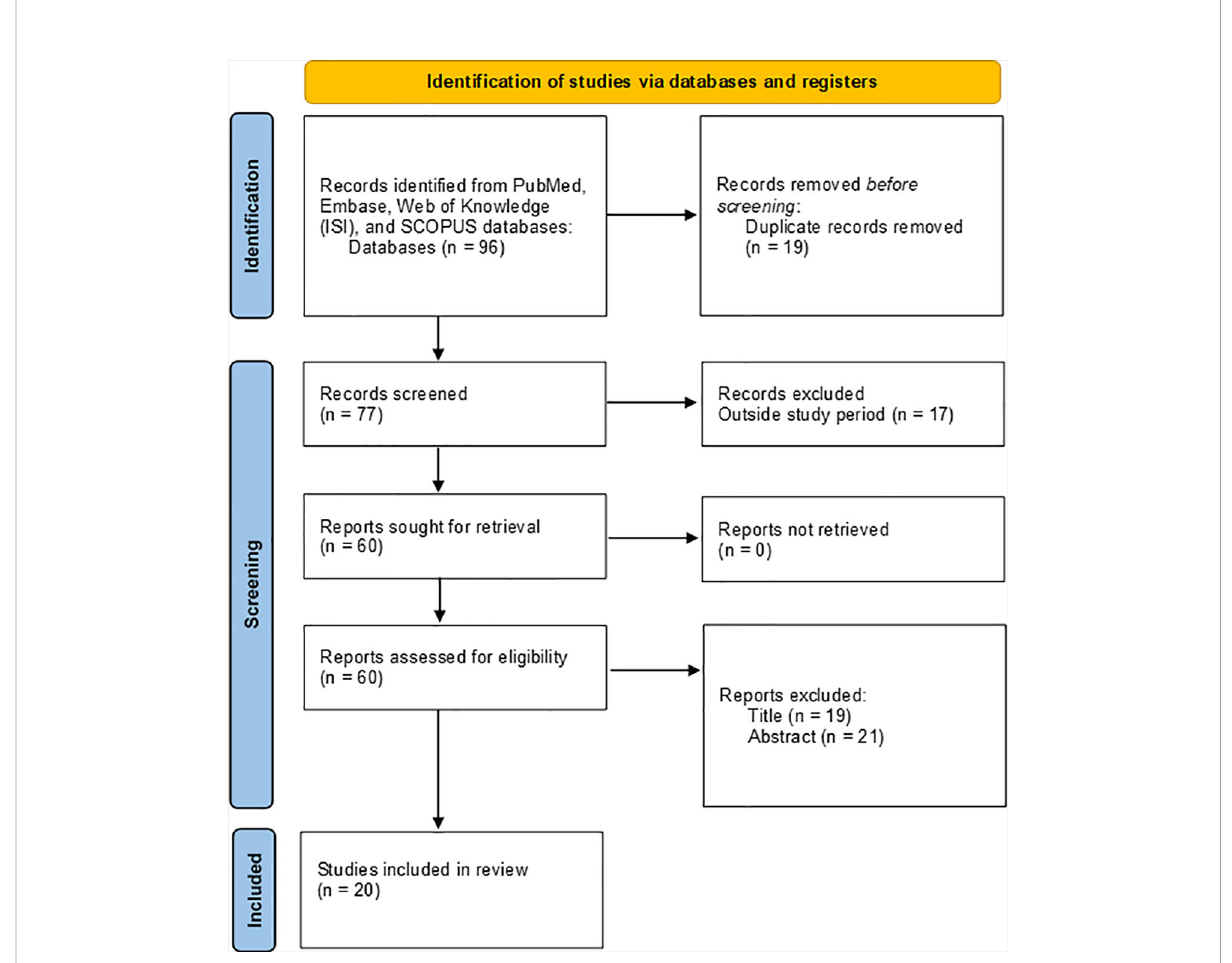
FIGURE 1 PRISMA fl ow diagram used in this systematic